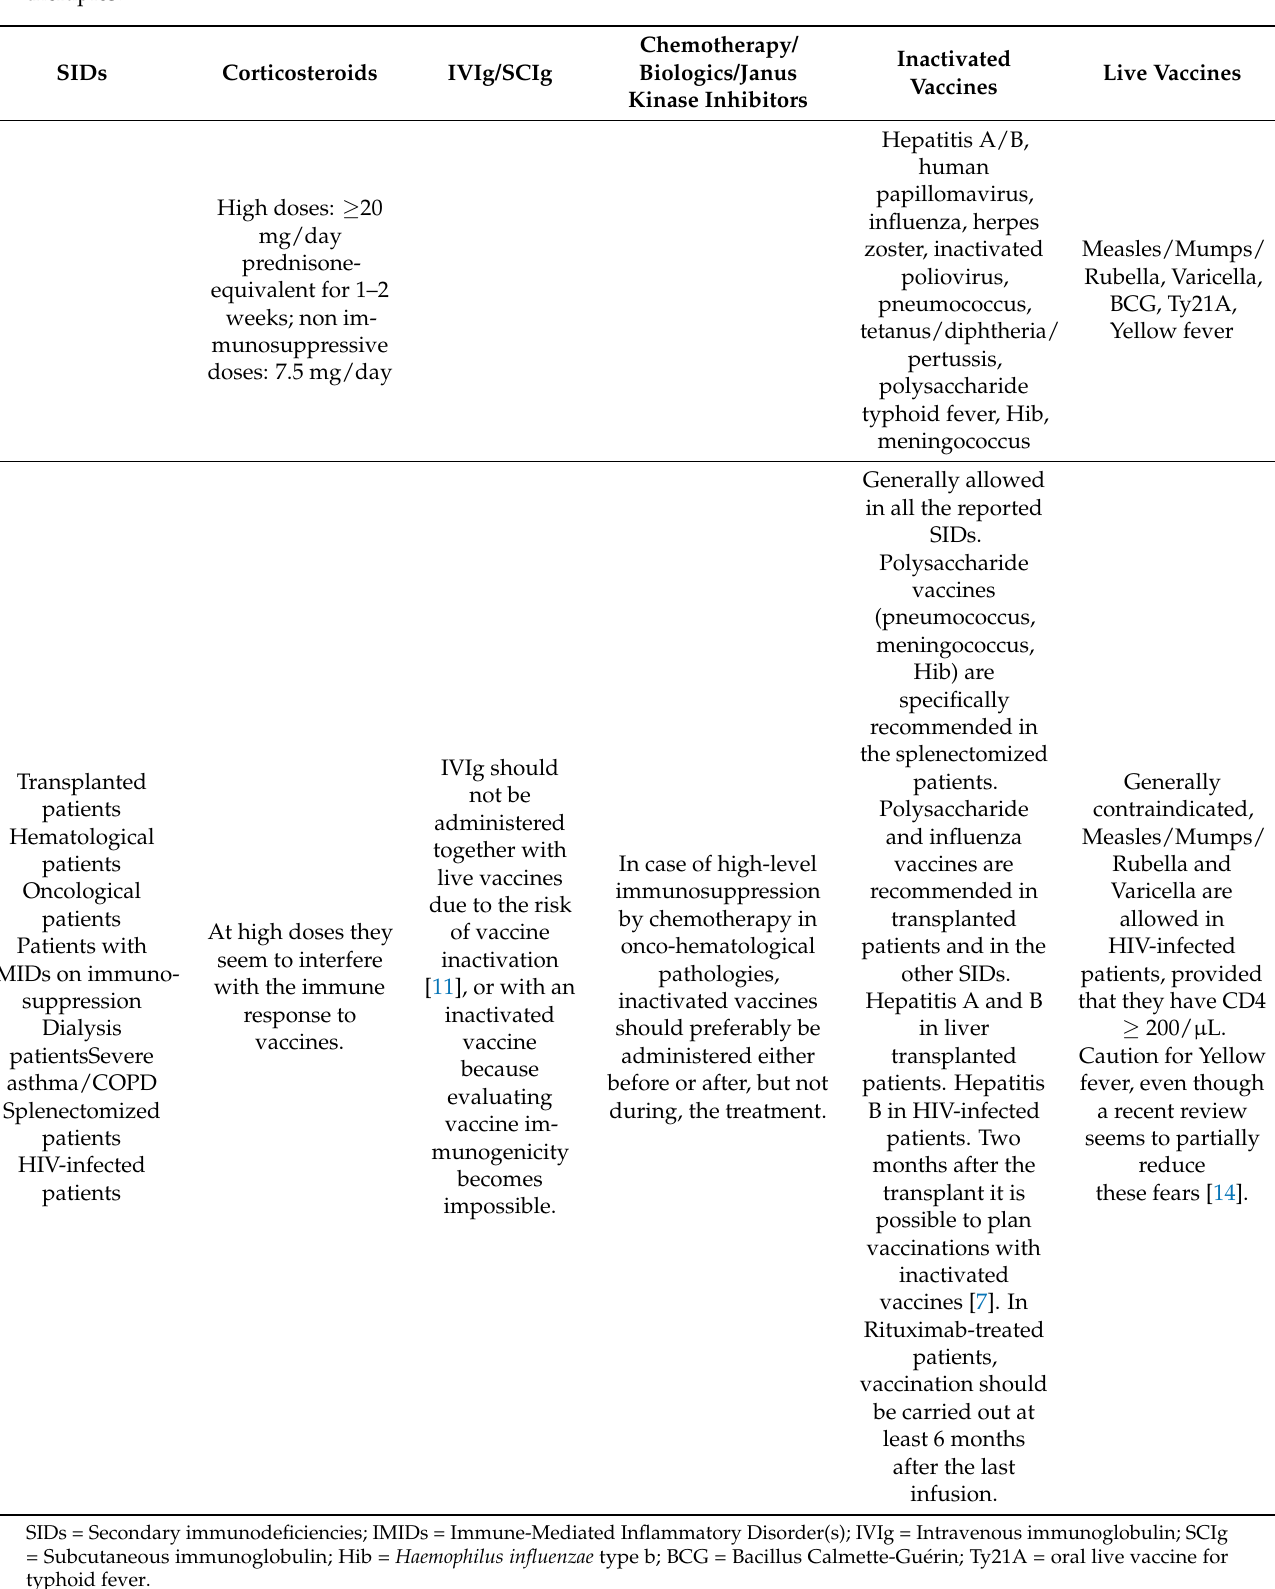
Table 3. Inactivated and live traditional vaccines (not anti-COVID-19) in patients with SIDs and influence of the relative